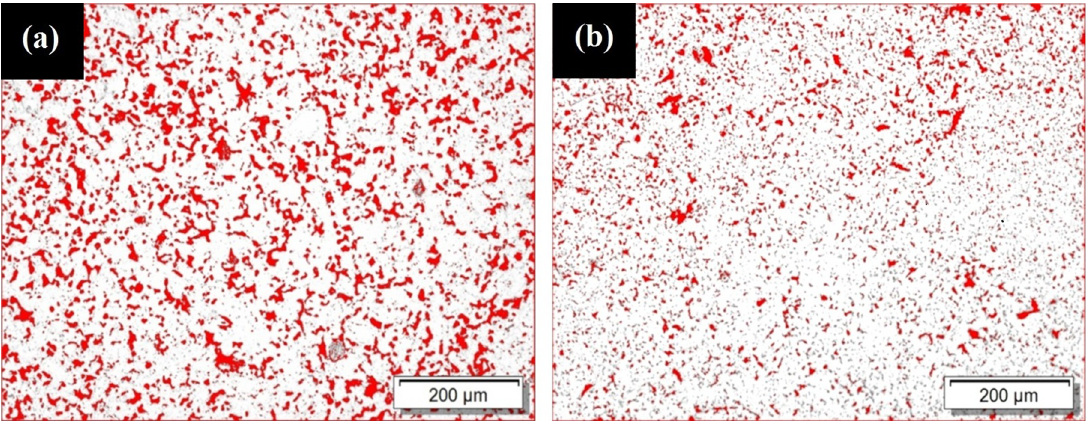
Figure 8. Porosity analysis of the AISI 52100 steel (a) Pure (b) With 3% of